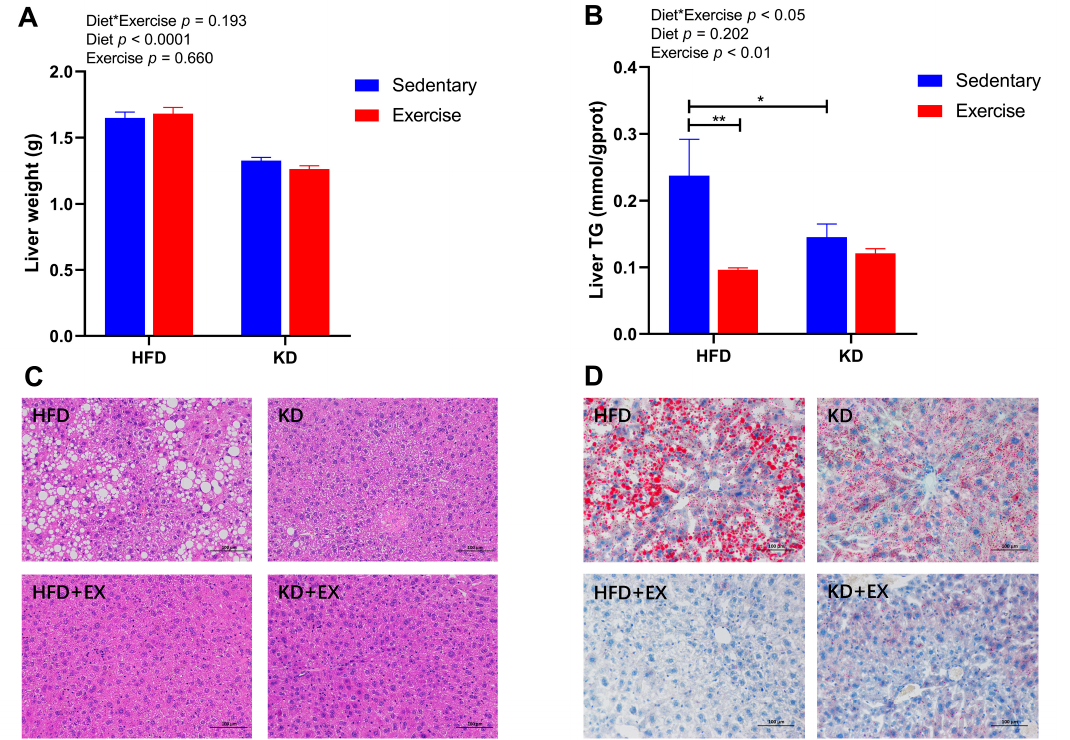
Figure 5. Effects of KD intervention and KD combined with exercise on hepatic lipid accumulation and hepatic steatosis. ( A ) Liver weight (n = 8). ( B ) Quantification of liver TG; ( C ) Representative images of HE staining of liver sections (Scale bars = 100 µ m; Original magnification, 200 × ); ( D ) Representative images of Oil-red O staining of liver sections (Scale bars = 100 µ m; Original magnification, 200 × ) (n = 5–6). Data are presented as mean ± SEM. For panels A and B , p values from the two-way ANOVA (i.e., main diet and exercise effects and diet*exercise interactions) are presented in the top left corner; Bonferroni post hoc test indicated significant differences (identified with an asterisk) at the following p values, * p < 0.05; ** p < 0.01.